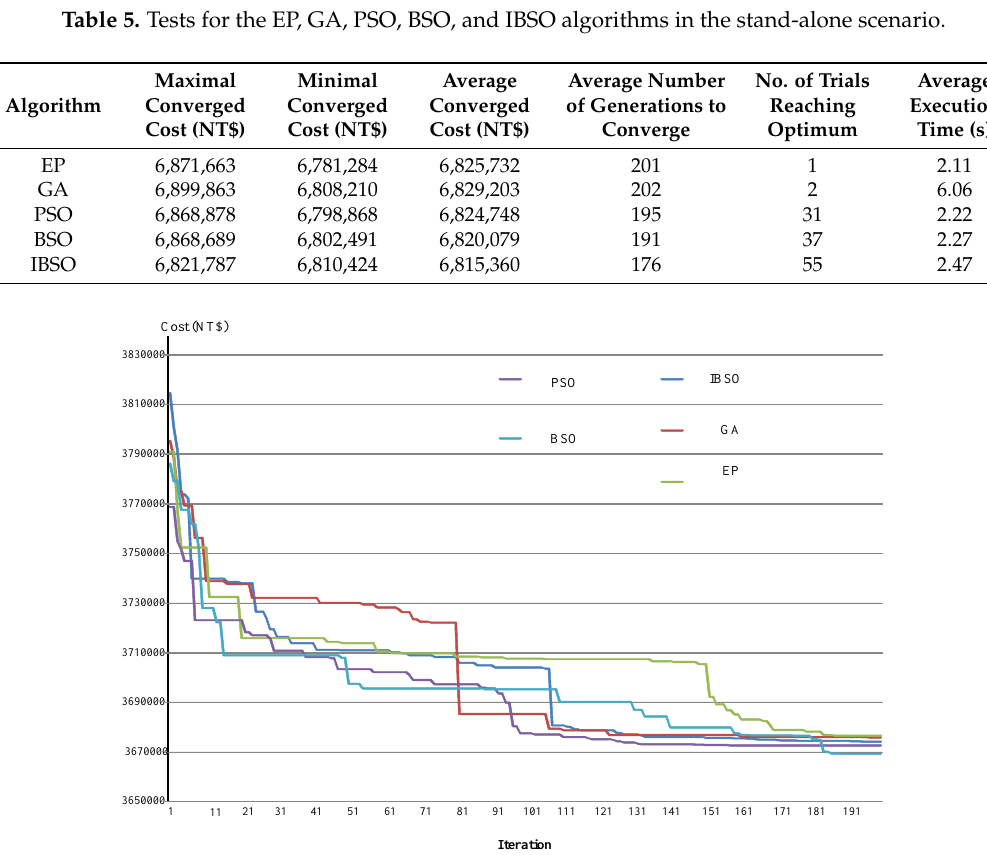
Figure 14. Convergence characteristics of the EP, GA, PSO, BSO, and IBSO algorithms in the stand-alone scenario.